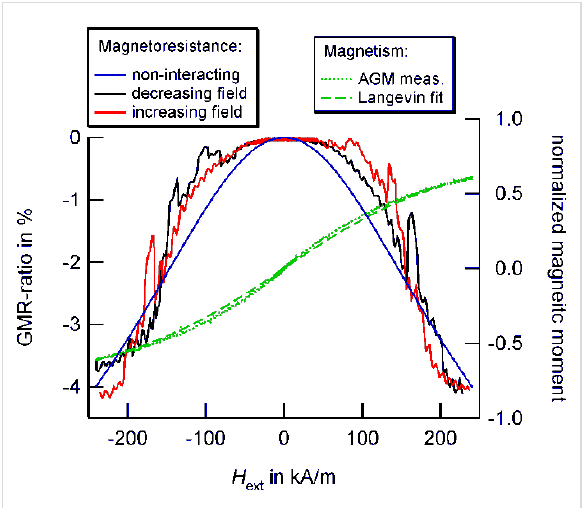
Figure 14: GMR response of a monolayer consisting of 8 nm Co parti- cles covered by a thin Cu film. Measurements were taken at room temperature with a sample current of 1 mA and an in-plane external magnetic field. In comparison to the prediction of non-interacing parti- cles, the experiments show additional features at field values of about ±176 kA/m, ±136 kA/m and ±88 kA/m.